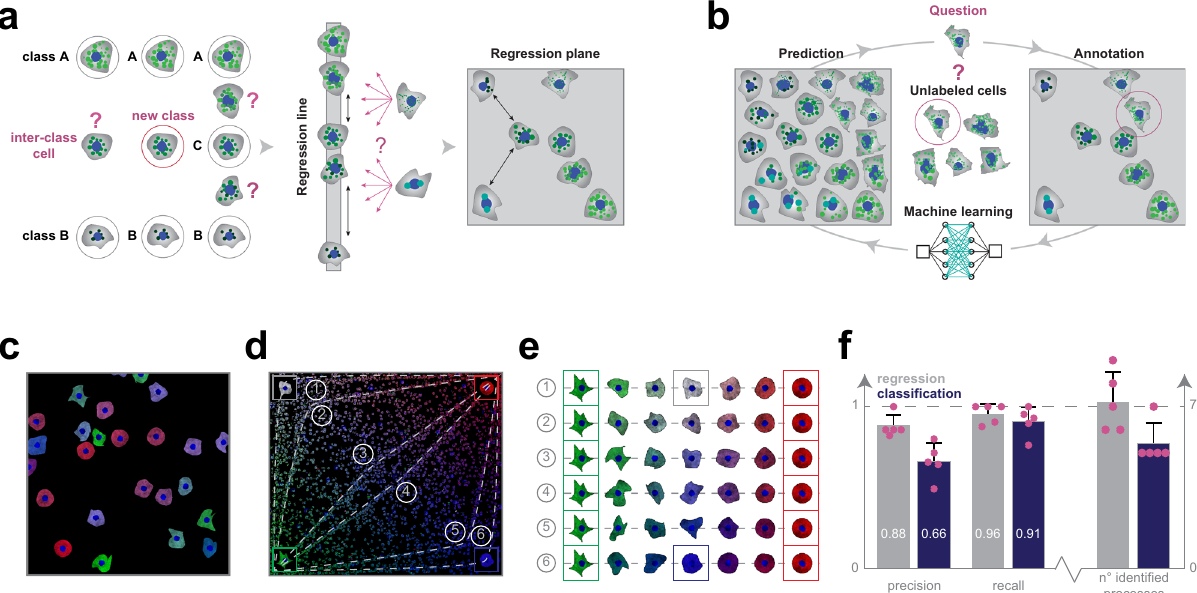
Fig. 1 Classi fi cation vs regression. a Regression plane concept. The classical way to model a biological process includes the phenotypical analysis of cells (i.e. subdividing cells into classes). However, in a high-content screening scenario, the multitude of different phenotypes makes it extremely challenging to create a set of representative classes. A possible solution builds on using a regression line, allowing to represent a single effect without the need of discretization. Nonetheless, biological processes are typically characterized by numerous ongoing effects. Thus, the regression plane represents a good trade-off between visualization capabilities and annotation complexity. Basically, it allows to represent a biological process with the limits of a planar graph. b Active regression. The aim of an active regression algorithm is to improve the training set (TS) to achieve better prediction performance. It is an iterative process where a cell that is dif fi cult to annotate is proposed to the oracle who annotates it, and by doing so moves it to the TS used to train the regression model. c Synthetic dataset. Image from the synthetic dataset, generated using SIMCEP. d Experimental design. The designed processes overlayed on the space of perturbations. 6 processes are tracks in the space, and an extra process is formed of uniformly distributed cells (latent process 7). e Designed processes. The 6 continuous processes are modelled between two fi xed endpoints: green cells of highly irregular shape and red, rounded cells. To assign a colour to the middle point of each process we interpolated between white (process 1) and blue (process 6). f Classi fi cation vs regression applied on synthetic data. Comparison of the performance of regression and classi fi cation. Statistics: precision, recall and the number of identi fi ed processes. Columns represent mean, error bars show the standard deviations from n = 5 independent users/experimental setup. Source data are provided as a Source Data fi